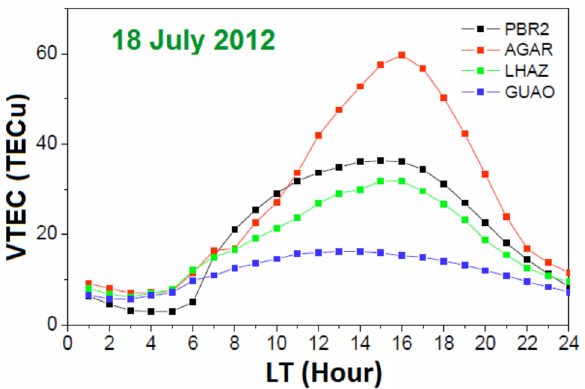
Figure 2. Variation of TEC on a typical day 05 May-2012 at four dif- ferent stations, Port Blair (Geomagnetic lat. 2.11°N), Agartala (Ge- omagnetic lat. 14.22°N), Lhasa (Geomagnetic lat. 20.09°N) and Urumqi (Geomagnetic lat.